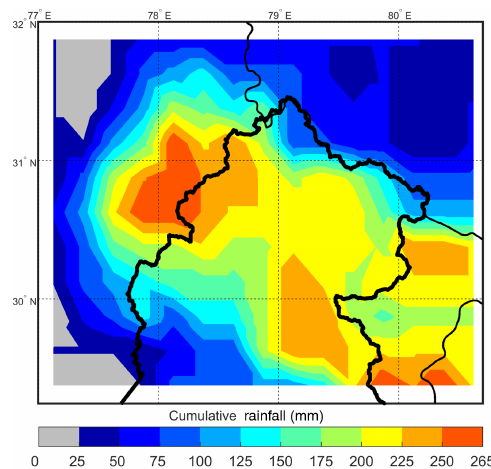
Figure 3. Cumulative rainfall in the upstream region of the UGB obtained from the Tropical Rainfall Measuring Mission (TRMM) Multi-Satellite Precipitation Analysis (TMPA) 3B42RTV7 product at 0.25 ◦ resolution. The domain shown is similar to the insert shown in Fig. 2.